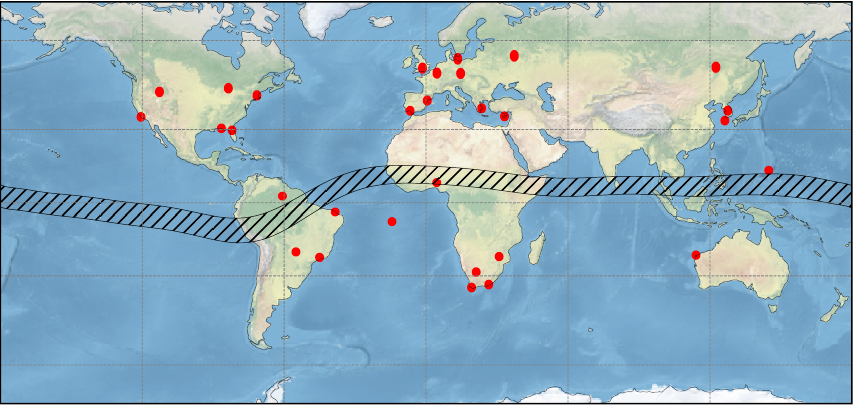
Figure 1. A map of the areas around Digisonde sites corresponding to a radius of 170 km used to calculate E s occurrence rates from GPS-RO measurements. The shadowed region corresponds to ± 10 ◦ of geomagnetic